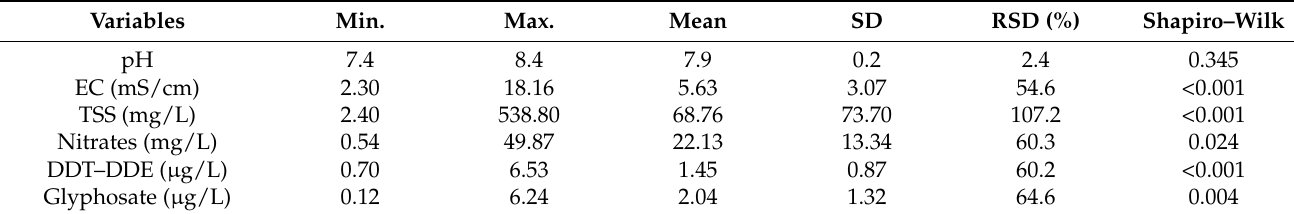
Table 1. Descriptive statistics of the water characteristics of the drainage channels: minimum and maximum values, arith- metic mean, standard deviation (SD), and relative standard deviation (RSD). Shapiro–Wilk test of normality was included. Variables Min.